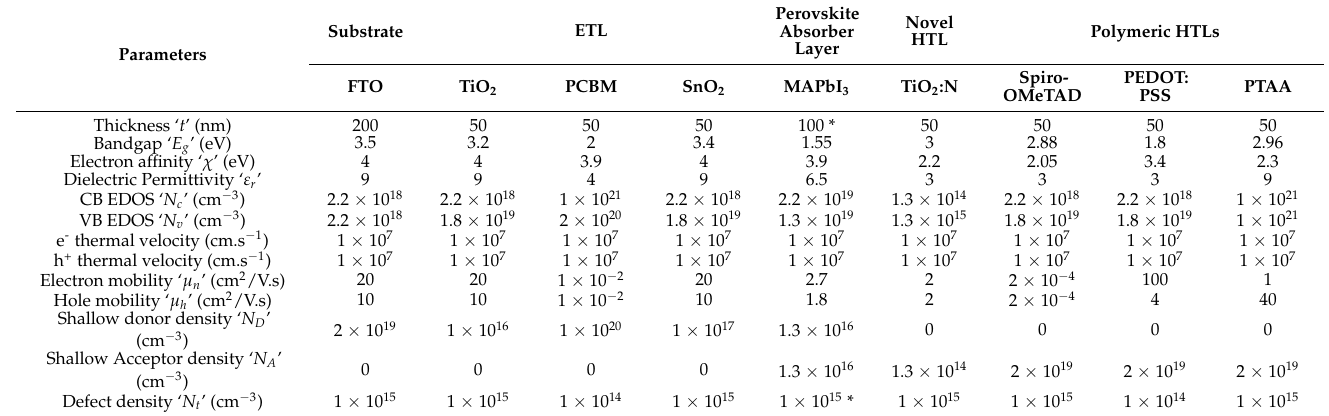
Table 5. The proposed electrical parameter considered for software simulation of PSC structures [62–71].